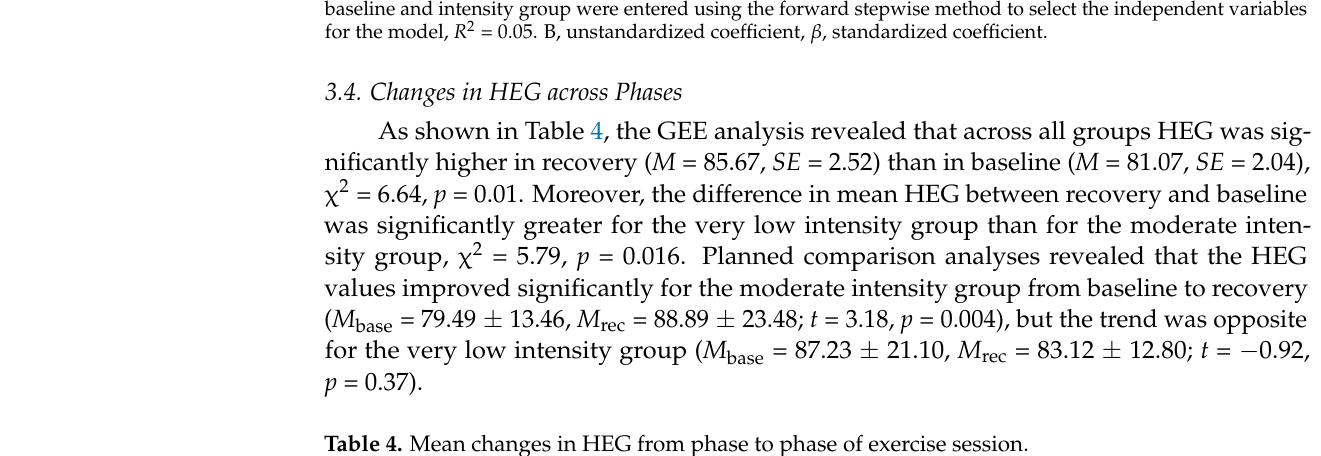
Table 4. Mean changes in HEG from phase to phase of exercise